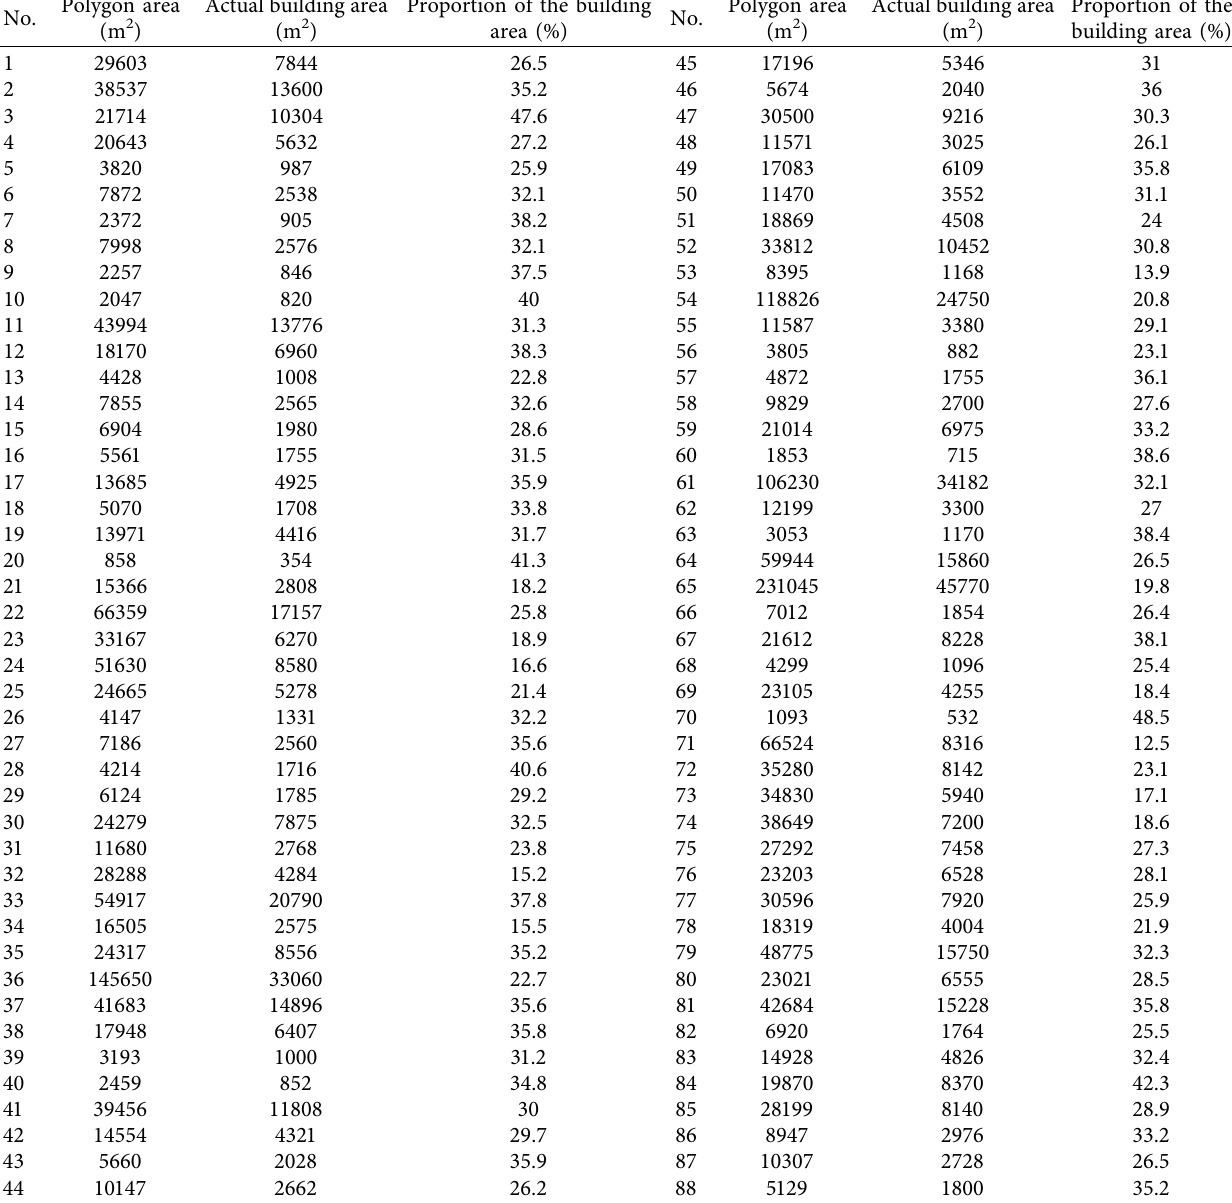
Table 2: Proportions of the areas of GS buildings determined based on field survey data.